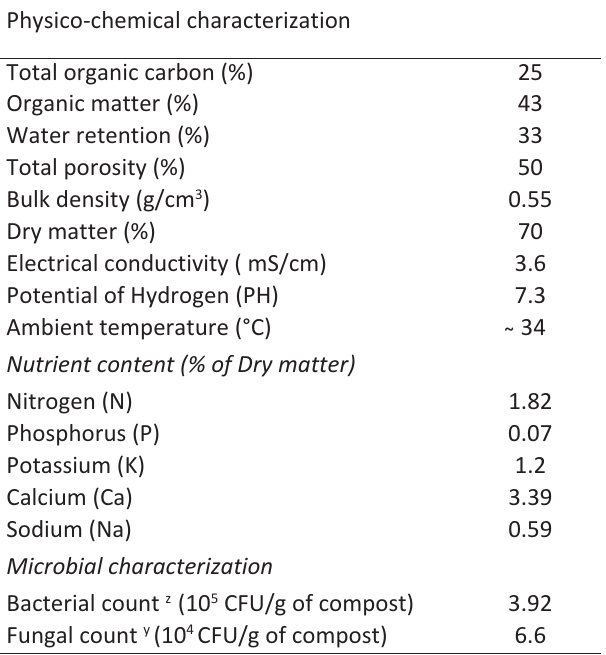
Table 3 ­ The physico­chemical and microbial characterization Physico­chemical